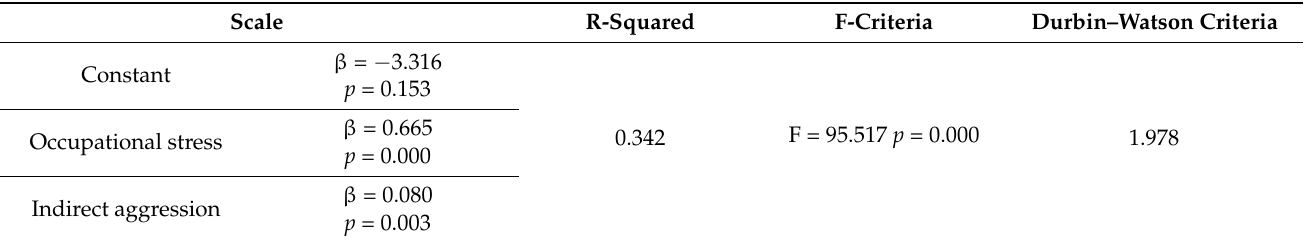
Table 7. Assessment of the contribution of occupational stress and indirect aggression to the develop- ment of emotional exhaustion in non-COVID-19 ICU HCWs.